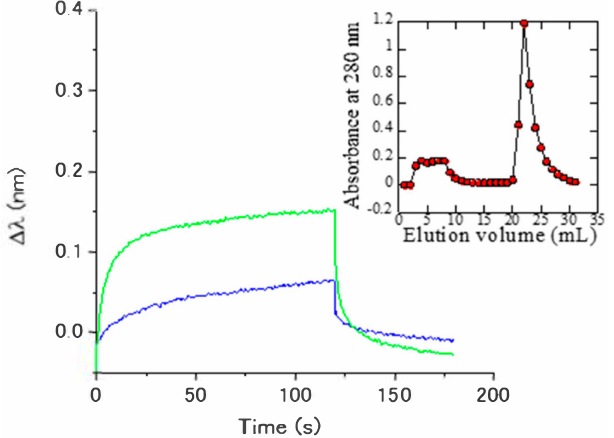
Figure 2. Mannose binding ability of separated ConA eluent in the first peak (blue) and in the second peak (green). Insert: Absorbance change in eluted solution of